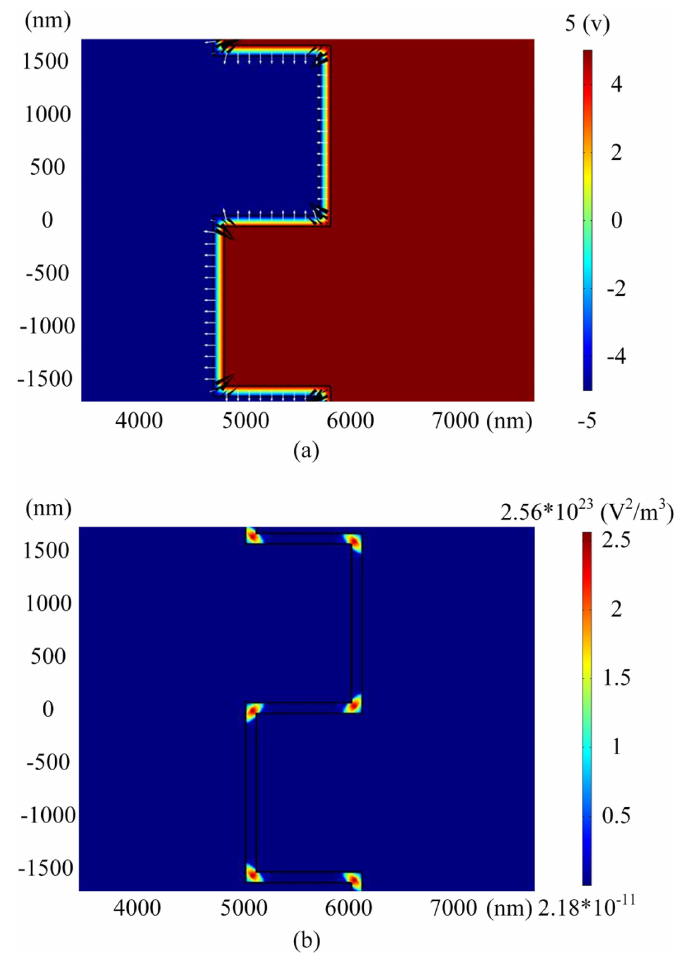
Figure 9. Numerical simulation of potential, electric field, and ∇ E 2 generated by an external AC voltage. ( a ) Potential and direction of electric field and ∇ E 2 and ( b ) ∇ E 2 magnitude distribution.